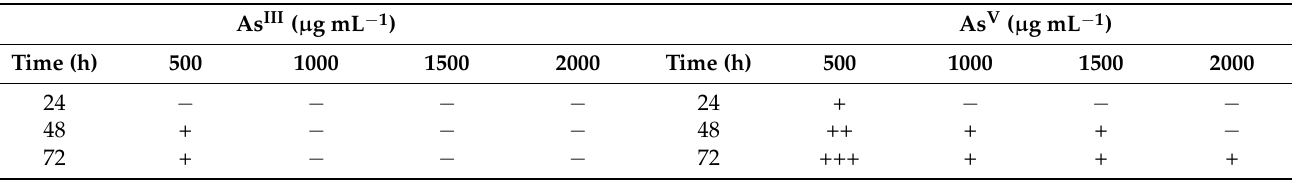
Table 3. B . licheniformis B3-15 growth in MB 1 plus As III or As V at different concentrations. Absorbance 4 values (OD 600nm ) ≤ 0.2 were indicative for “no growth” ( − ), those ranging from 0.2 to 0.5 for “low